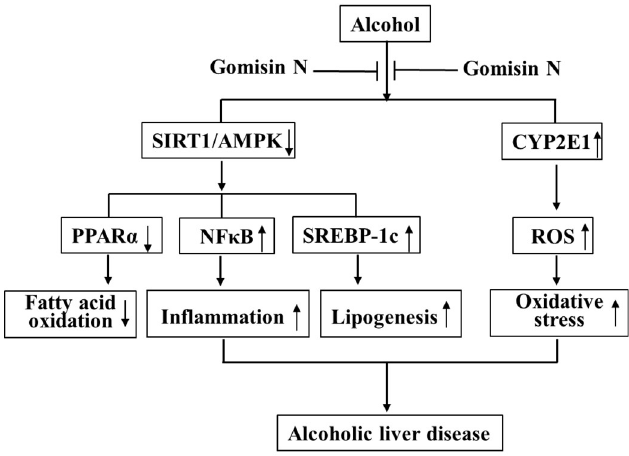
Figure 10. Schematic representation of the proposed mechanism by which GN protects against alcoholic liver disease (ALD) by inhibiting hepatic steatosis, oxidative stress, and inflammation. GN exerts potential hepatoprotective effects against ethanol-induced liver injury by activating SIRT1/AMPK and inhibiting CYP2E1. ↑ means upregulation and ↓ means downregulation